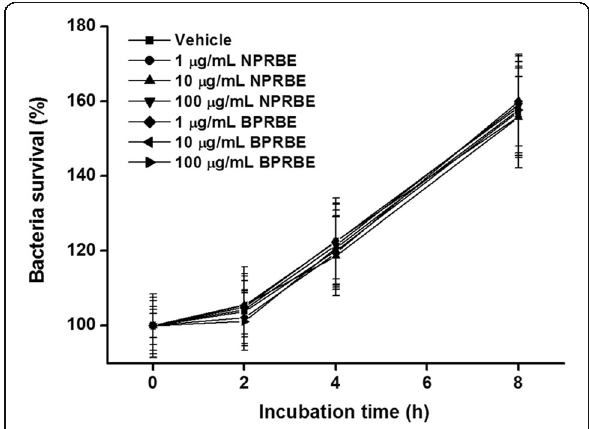
Fig. 1 Effects of BPRBE and NPRBE on growth of S . Typhimurium. Serially diluted BPRBE and NPRBE (1, 10, and 100 μ g/mL) were incubated with S . Typhimurium (2 × 10 4 CFU) for 2, 4, 6, and 8 h. Plotted values are mean ± SD of triplicate